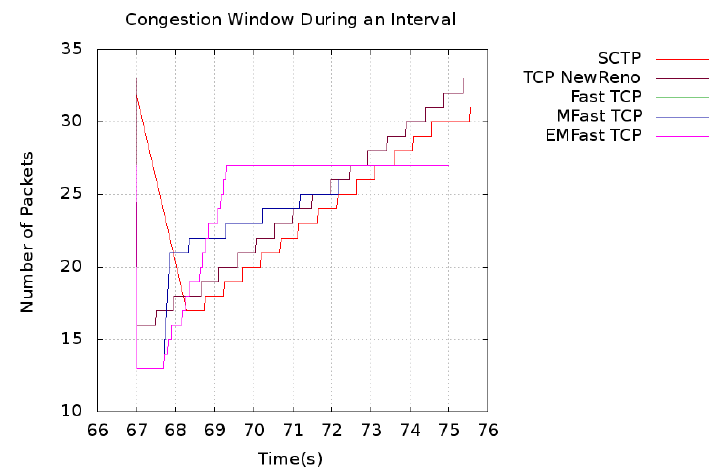
Figure 9. Congestion window graph during the interval of packet drop and after fast-recovery stage (with four competing flows).